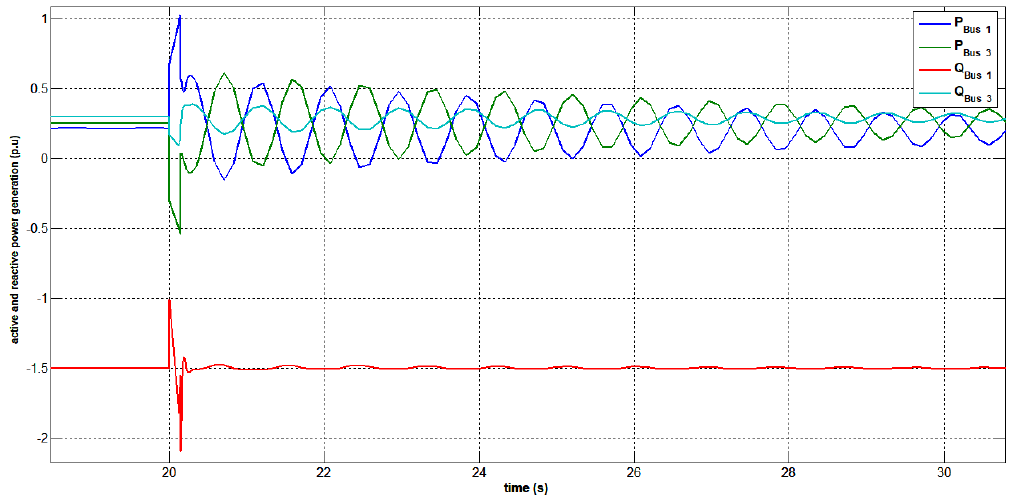
Figure 51. Generated active and reactive power at buses 1 and 3 under a three-phase short circuit at bus 3 with STATCOM.